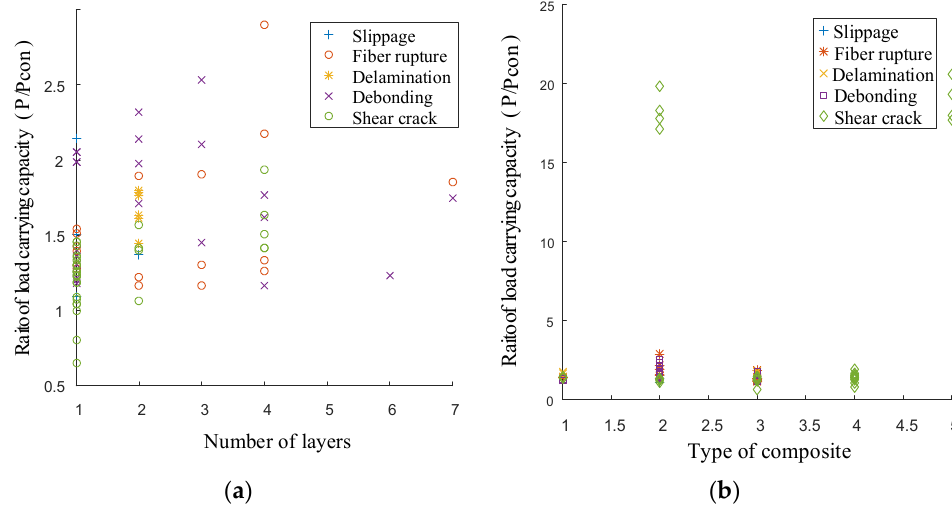
Table 9. The Percentage of FMs in strengthened beams under shear behavior in terms of composite type.